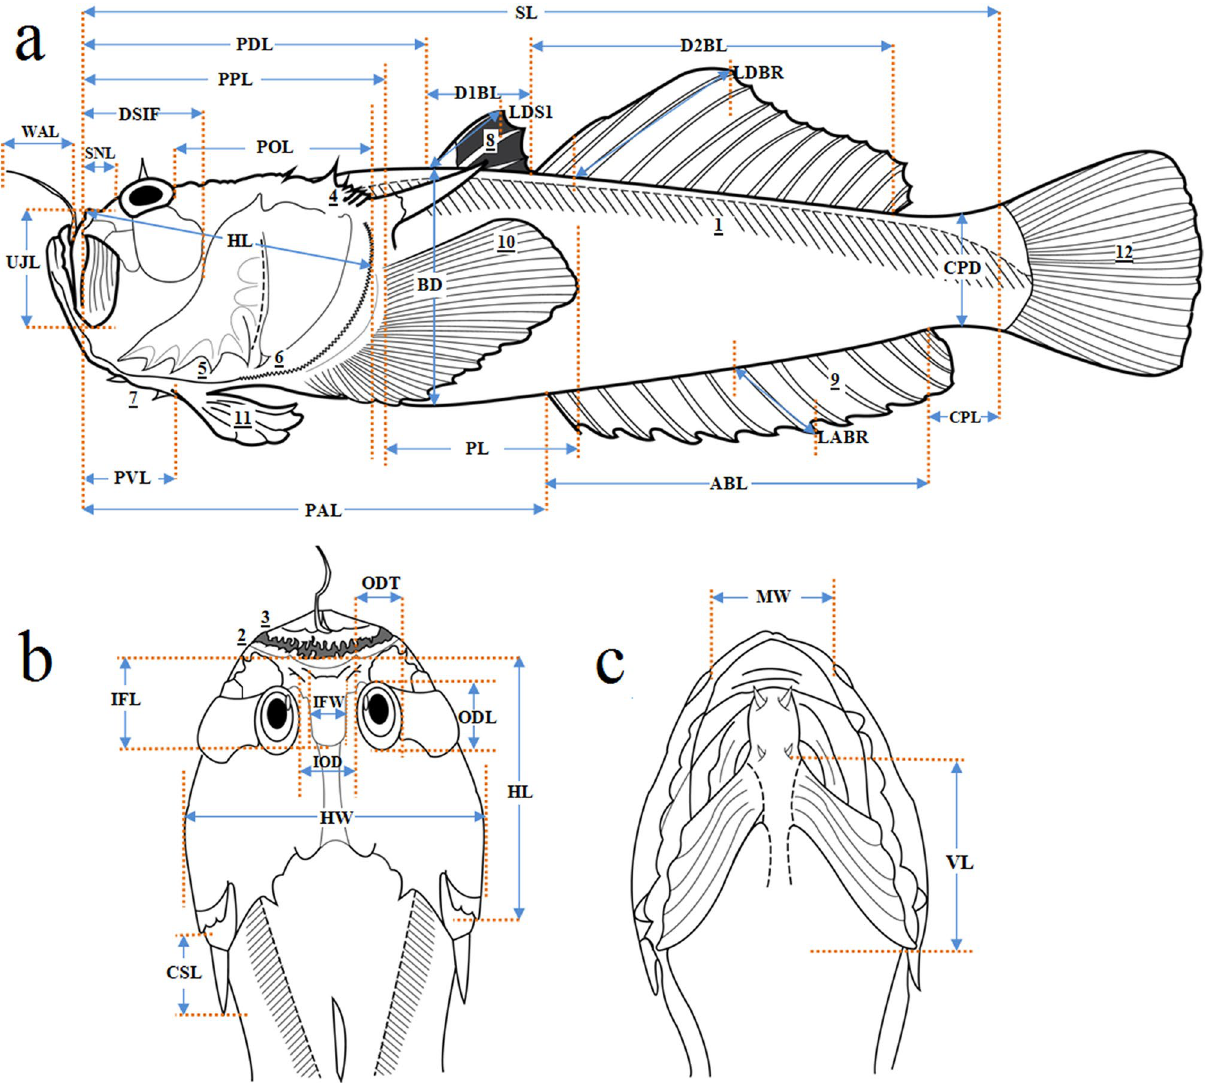
Figure 5. Linear morphometric measurement and meristic counts of Uranoscopus cognatus by ( a ) body side, ( b ) dorsal head view and ( c ) ventral head view. SL Standard length, BD body depth, HL head length, HW head width, ODL orbit diameter longitudinal line, ODT orbit diameter transversal line, IOD interorbital distance, IFL interorbital fossa length, IFW interorbital fossa width, DSIF the distance between the snout and the posterior margin of second infraorbital, UJL upper jaw length, SNL snout length, MW mouth width, POL postorbital length, WAL worm-like appendage length, CSL cleithral-spine length, PL pectoral fin length, VL pelvic fin length, D1BL first dorsal base length, D2BL second dorsal base length, LDS1 length of first dorsal spine, LDBR length of longest dorsal branched ray, ABL anal base length, LABR length of longest anal branched ray, PDL predorsal length, PAL preanal length, PPL prepectoral length, PVL prepelvic length, CPL caudal peduncle length, CPD caudal peduncle depth; number of scale rows on body (1), upper lip fimbriae (2), lower lip fimbriae (3), supracleithral spines (4), preopercular spines (5), subopercular spines (6), basipterygial processes (7), dorsal fin rays (8), anal fin rays (9), pectoral fin rays (10), pelvic fin rays (11), and branched caudal rays